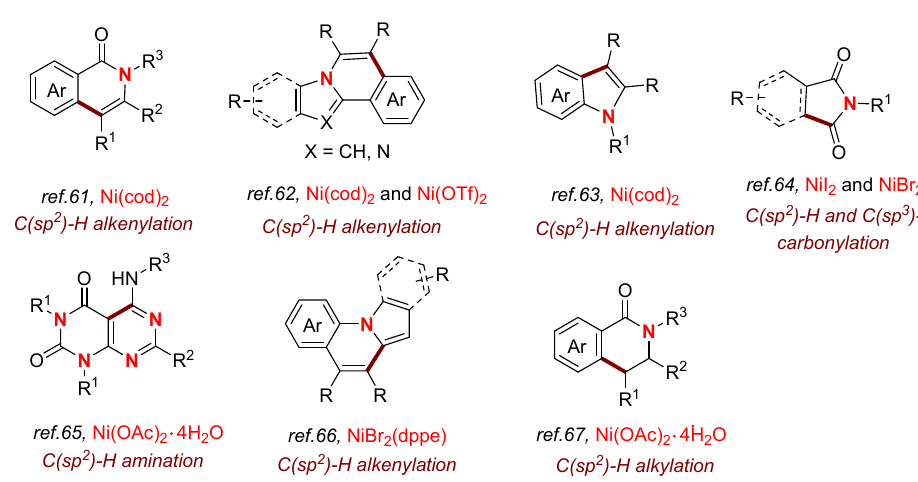
Figure 1. Outline of nickel-catalyzed C ‒ H functionalization for N -heterocycle synthesis.